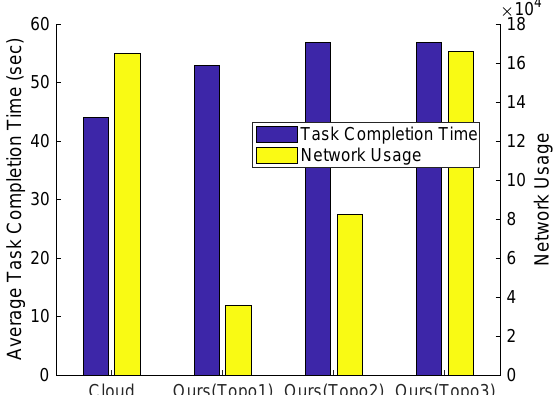
Figure 18. Distributed computation offloading vs. centralized cloud-based computation under 160 tasks and a 60 s